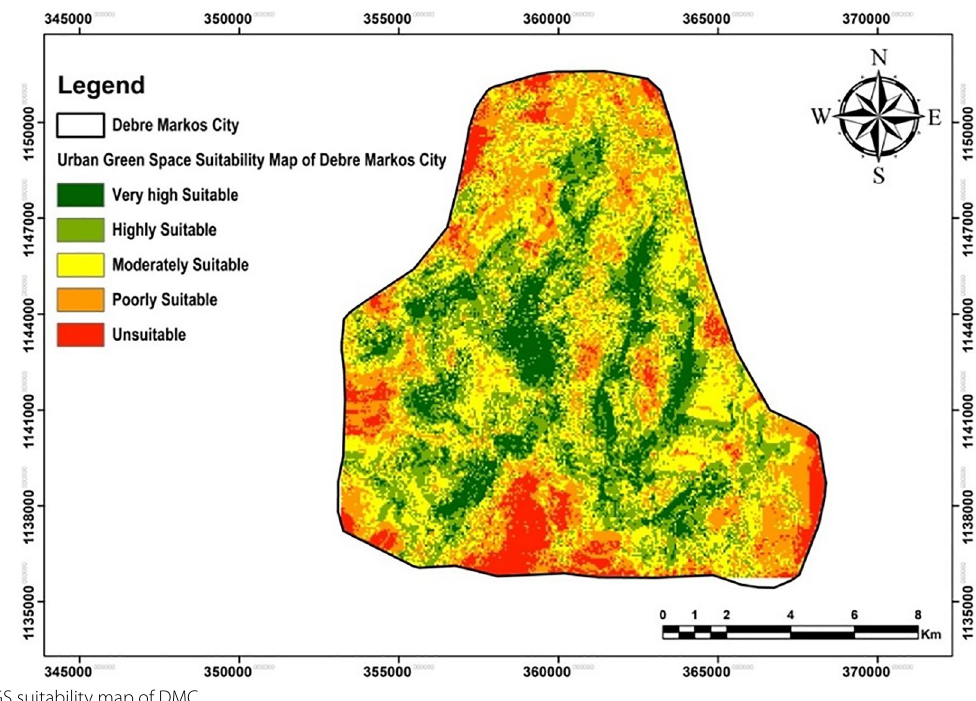
Fig. 10 UGS suitability map of DMC